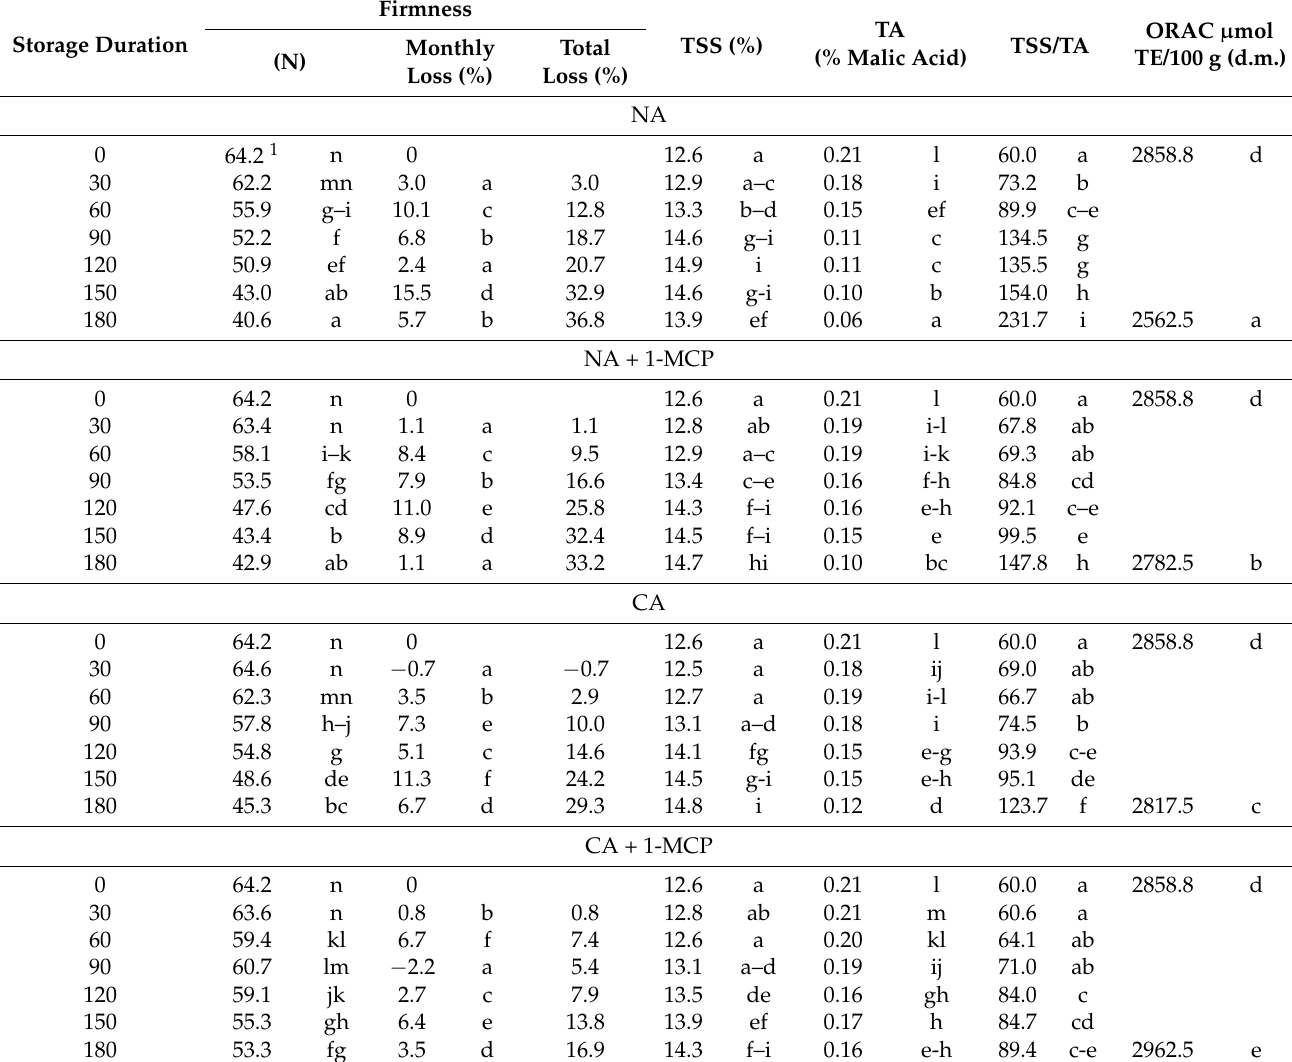
1 One-way analyses of variance; data in the same column marked with the same letter are not significantly different within a year at α = 0.05 (Duncan’s test). NA—normal atmosphere; NA + 1-MCP—normal atmosphere + 1-methylcyclopropene; CA—controlled atmosphere; CA + 1-MCP—controlled atmosphere +